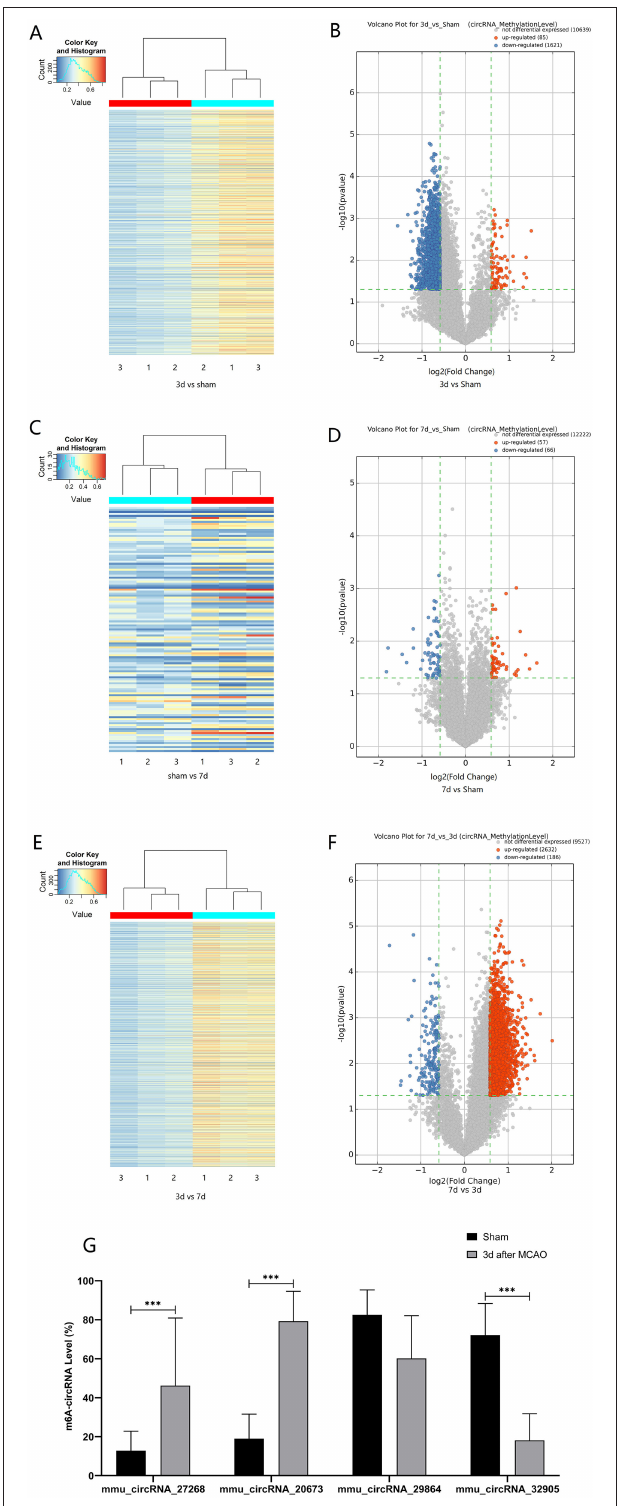
FIGURE 3 | Alteration of m 6 A methylated-circRNAs. Different methylation modification in circRNAs in 3d (A) or 7d (C) vs. sham and 7d vs. 3d (E) are shown in heatmaps. The volcano plots display differentially m 6 A-methylated